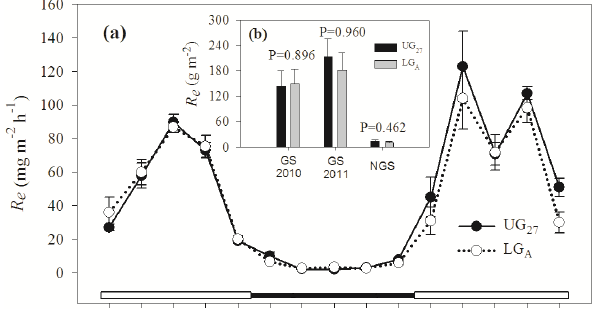
Fig. 2. Rates of CO 2 emission with ecosystem respiration ( R e ) (a) and the magnitude of CO 2 fluxes within and outside the growing season (b) at sites UG 27 (ungrazed since 1984) and LG A (grazed in winter) using the static closed chamber method. White and black horizontal bars represent within the growing season (GS, 2010 and 2011) and outside the growing season (NGS), respectively.